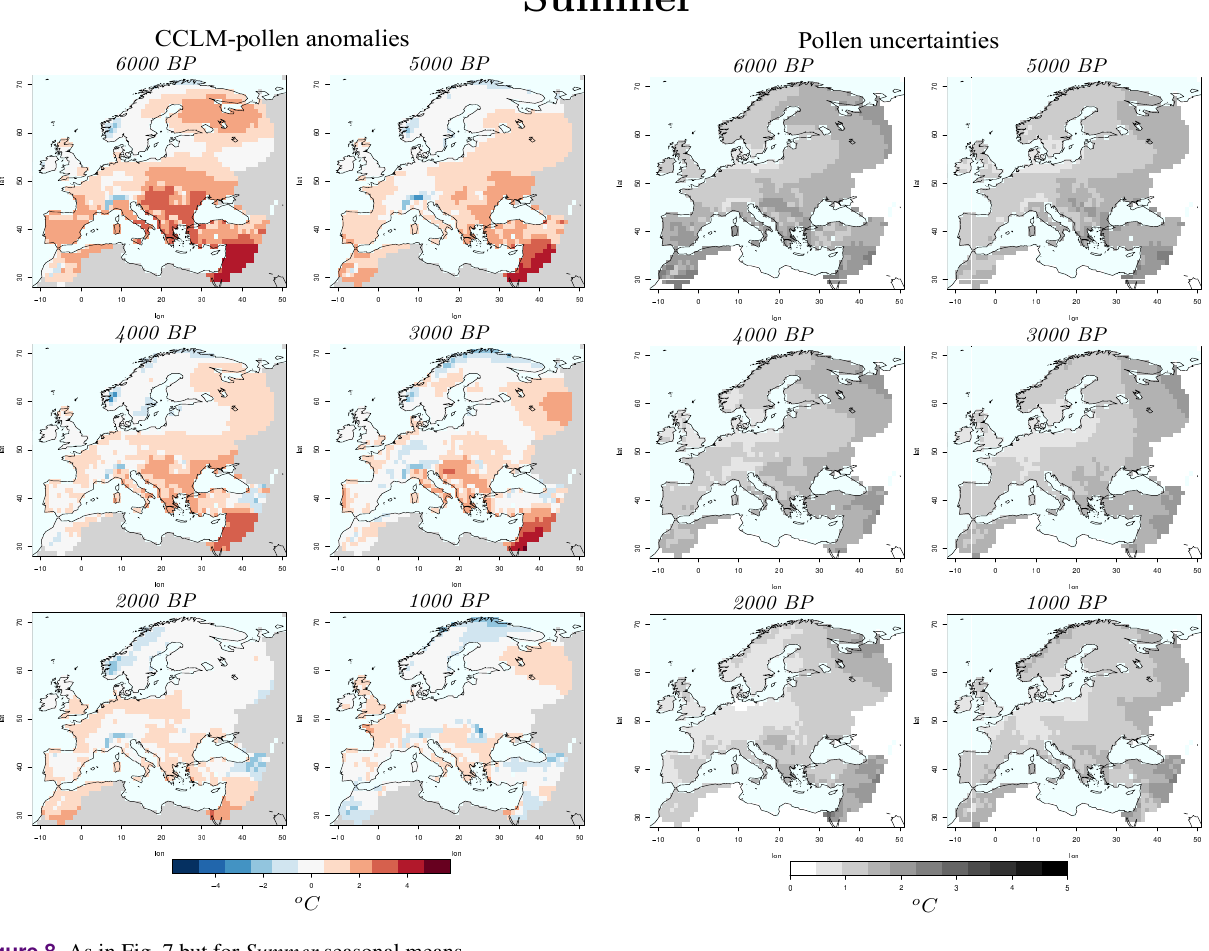
Figure 8. As in Fig. 7 but for Summer seasonal means.